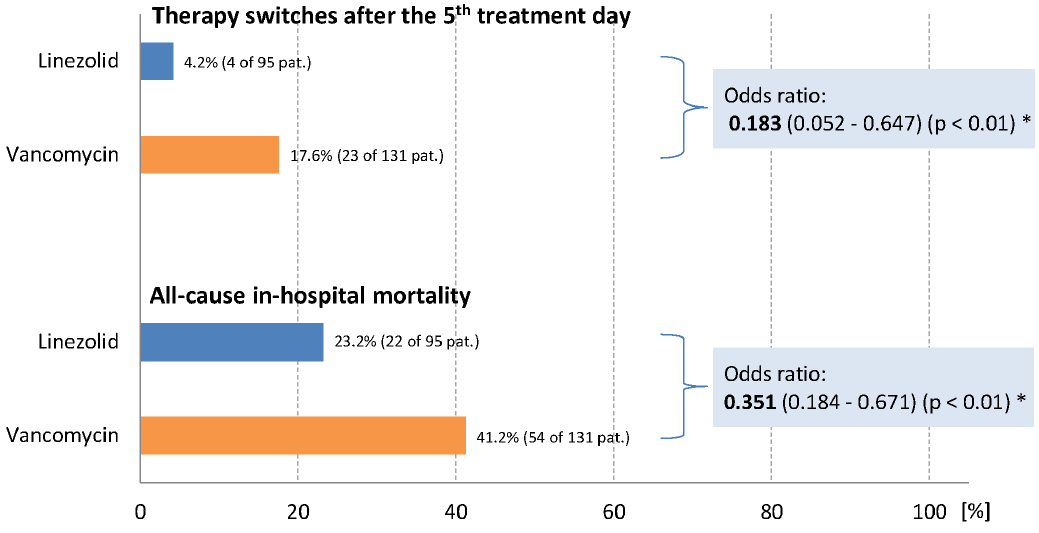
Figure 1: Switches to another antibiotic and in-hospital mortality rate